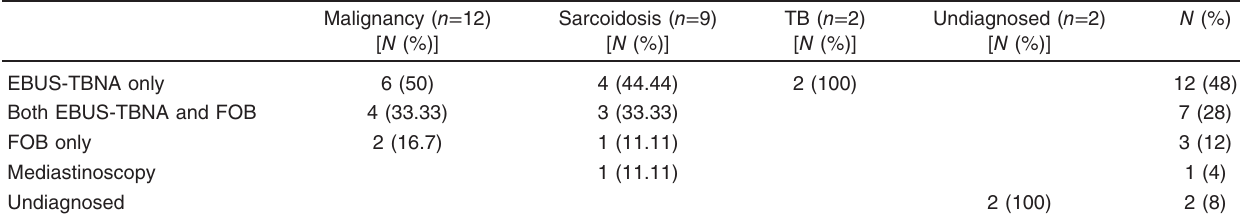
Table 4 Methods of final diagnosis of the studied cases Malignancy ( n = 12)